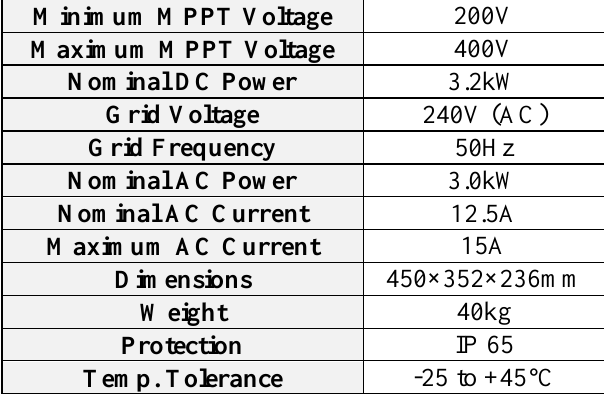
Table 4: Specifications of the inverter used in the